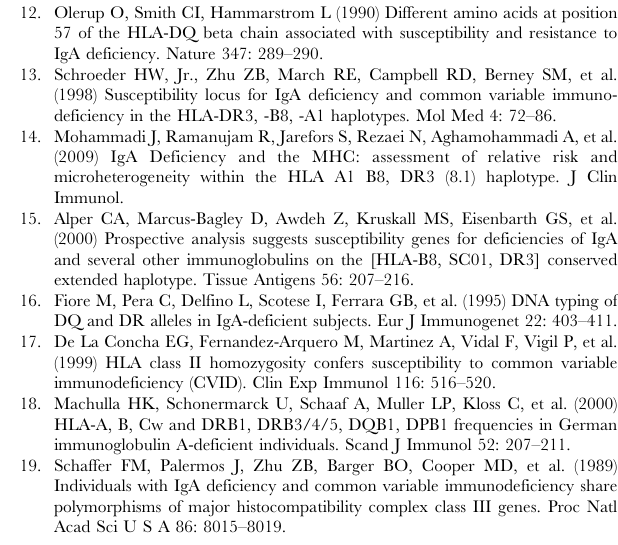
Figure S1 Residual association signal in the HLA locus following conditioning on all major association signals. Combined P values are shown for all SNPs and imputed HLA alleles, following conditional logistic regression analysis, using the genotypes at the HLA-B*0801-DRB1*0301-DQB1*02, -DRB1*0701-DQB1*02, - DRB1*0102 and -DRB1*15 alleles as covariates. Association results are represented as the 2 log 10 of the combined P values (left y-axis), and the most associated SNP (rs743862) and imputed HLA allele (B*1501) are marked by squares. Recombination rates from the HapMap CEU are depicted in blue (right y-axis). Genomic positions on the x-axis are based on the NCBI Build 36 (hg 18) assembly. The horizontal red line represents the genome-wide significance threshold of P =5 6 10 2 8 . Mb, megabase pairs. Table S1 Distribution of HLA-DRB1*0301 haplotypes in the 3 cases-control series. Shown are summary statistics for the distribution of extended and recombinant (non-B*0801) HLA- DRB1*0301 haplotypes in the 3 case-control series. P values were calculated using a two-tailed Fisher’s exact probability test comparing the frequency of recombinant DRB1*0301 haplotypes in cases and controls. Odds ratios were calculated relative to the lotypes. Combined P value and odds ratio were calculated using a Cochran-Mantel-Haenszel test. a Extended DR3 represent all